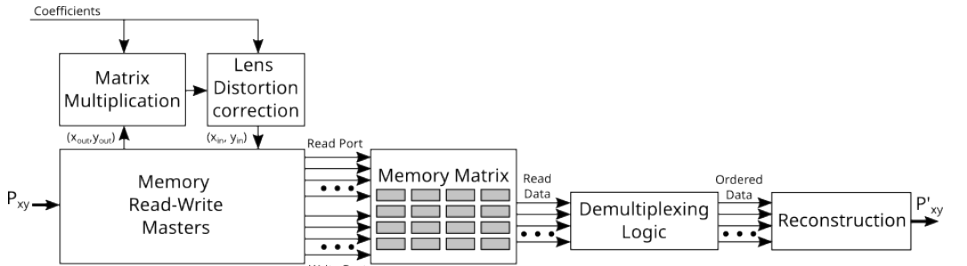
Figure 7. Functional architecture of the spatial image transformation